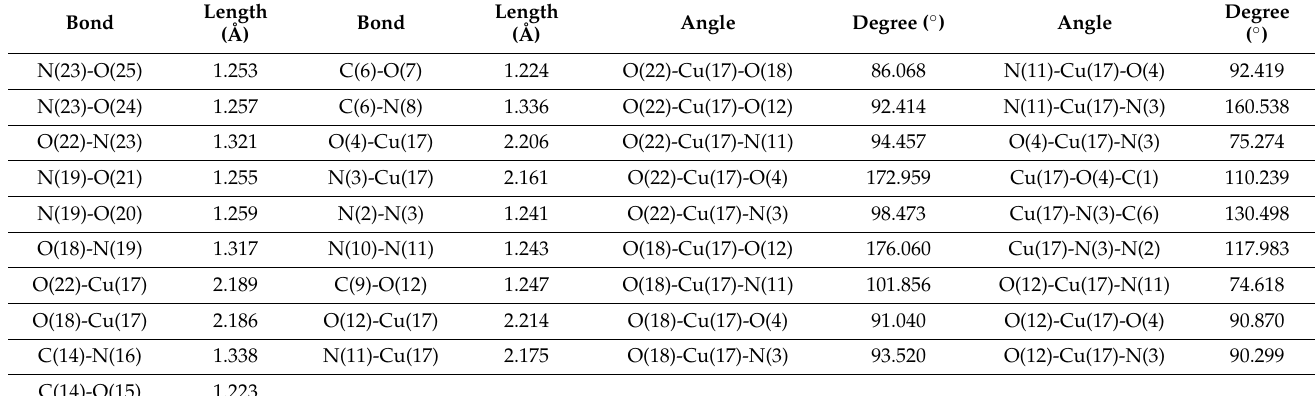
Table 7. Selected bond lengths (Å) and bond angles ( ◦ ) of (Cu complex) ligand using DFT-method from DMOL 3 calculations.